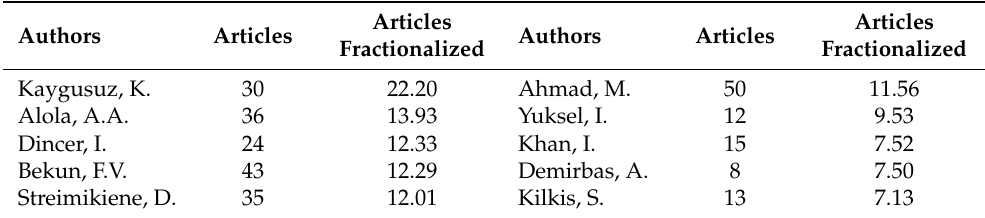
Table 4. Ranking of the top 10 most relevant authors based on the number of articles fractioned by the authors involved.